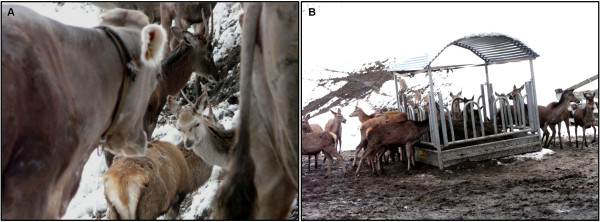
Interactions between red deer and cattle in Graubünden, Switzerland. (A) Encounter of < 50 m between cattle and red deer. (B) Red deer aggregation in relationship with anthropogenic food resources, here the use of hay silage for livestock in winter. Courtesy of Martin Michael.